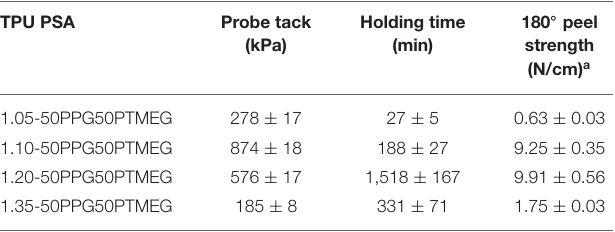
TABLE 4 | Probe tack at 25 ◦ C, holding time at 25 ◦ C, and 180 ◦ peel strength at 25 ◦ C of aluminum 5754/TPU PSA joints. TPU PSA Probe tack